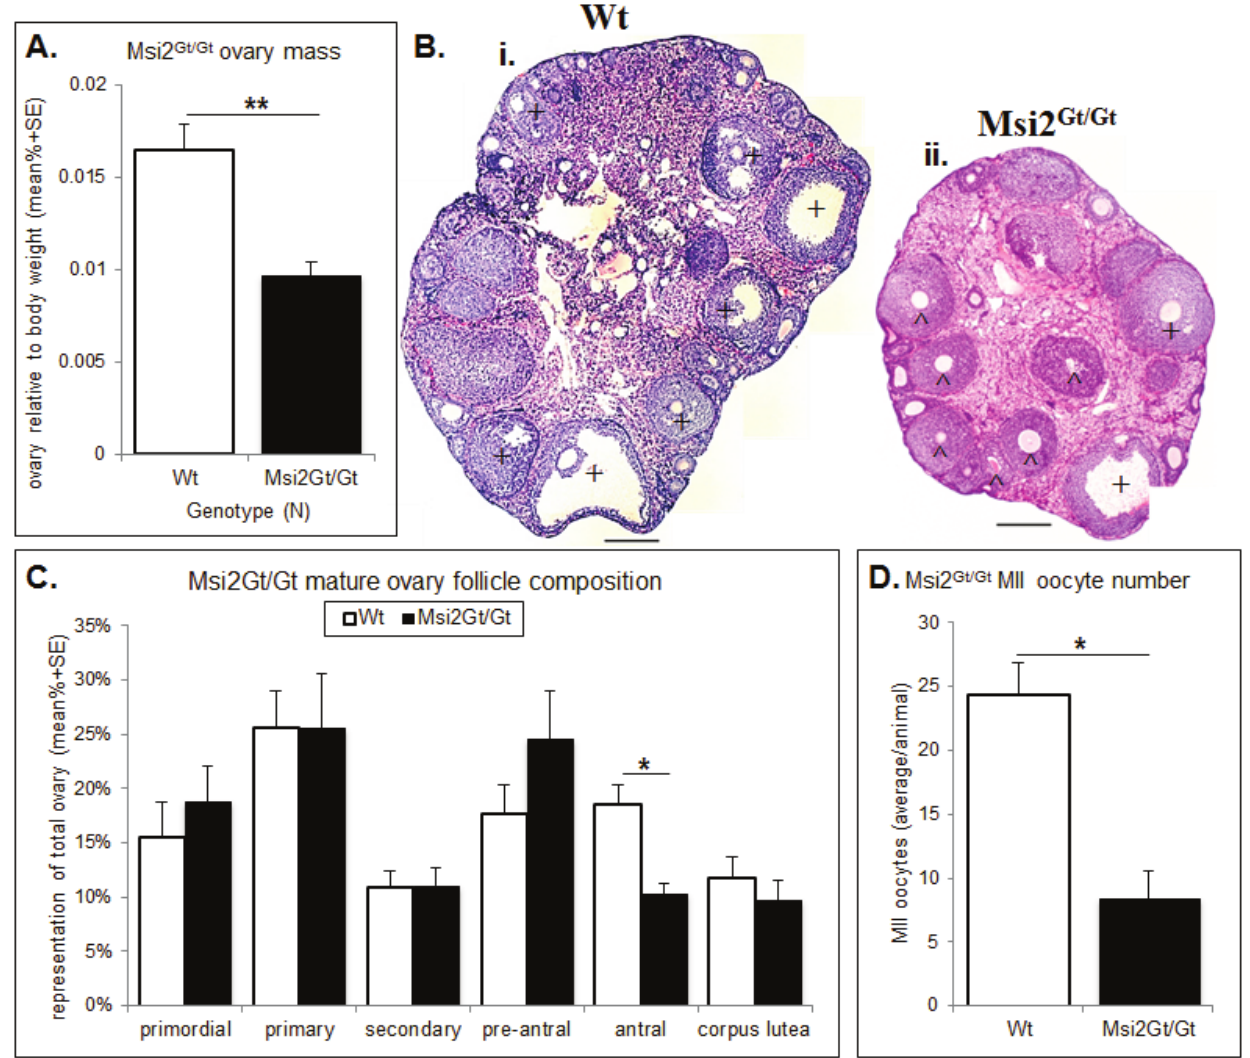
Figure 5. Histological analysis of the Msi2 Gt/Gt ovary and oocytes. ( A ) Mature Msi2 Gt/Gt ( n = 5) and Wt ( n = 8) ovary mass relative to body weight. Value presented as mean relative ovary mass/female/genotype + SE, **: denotes p < 0.01. ( B ) H & E image of Wt ( i ) and Msi2 Gt/Gt ( ii ) adult ovary cross-sections. Scale bar = 200 (cid:3)m. ^ indicates increased # of pre-antral follicles + indicates decreased # of antral follicles in Msi2 Gt/Gt ovary relative to Wt. ( C ) Mature Msi2 Gt/Gt and Wt follicle counts, values presented as mean % composition + SE, *: denotes p < 0.05). n = 7. ( D ) Msi2 Gt/Gt ( n = 9) and Wt ( n = 7) MII oocyte collection counts. MII oocytes were collected from the oviductal ampullae of super-ovulated adult mice and immediately counted, values are average oocytes/animal + SE, *: denotes p <